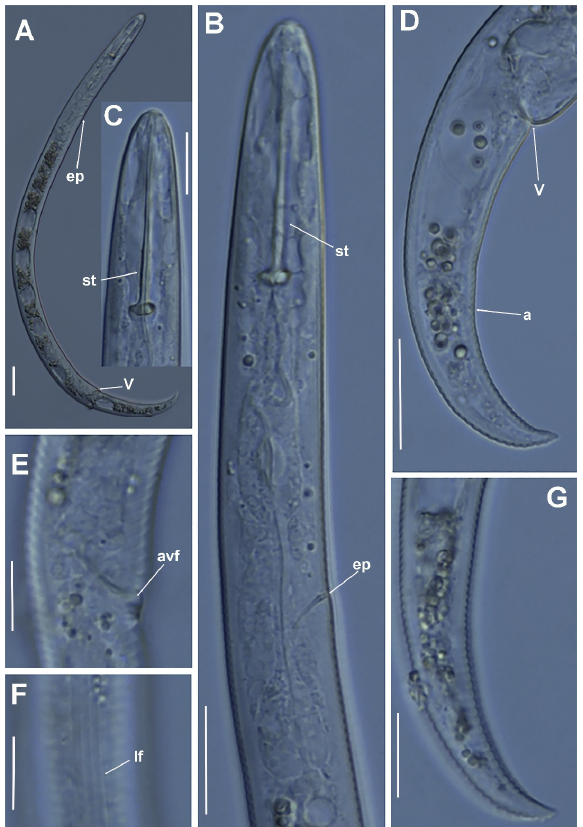
Figure 8. Micro-photomicrographs of Paratylenchus nanus Cobb, 1923 female. ( A ) Whole female with excretory pore and vulva arrowed; ( B ) Pharyngeal region with excretory pore arrowed; ( C ) Detail of stylet region; ( D,E ) Female posterior region with vulva and anus (arrowed) and detail of vulva showing advulval flap membrane (arrowed); ( F ) detail of lateral fields; ( G ) Detail of female tail. Scale bars ( A,B,D,G = 20 μ m; C,E,F = 10 μ m). (Abbreviations: a = anus; avf = advulval flap; ep = excretory pore; lf = lateral field; st = stylet; V = vulva).